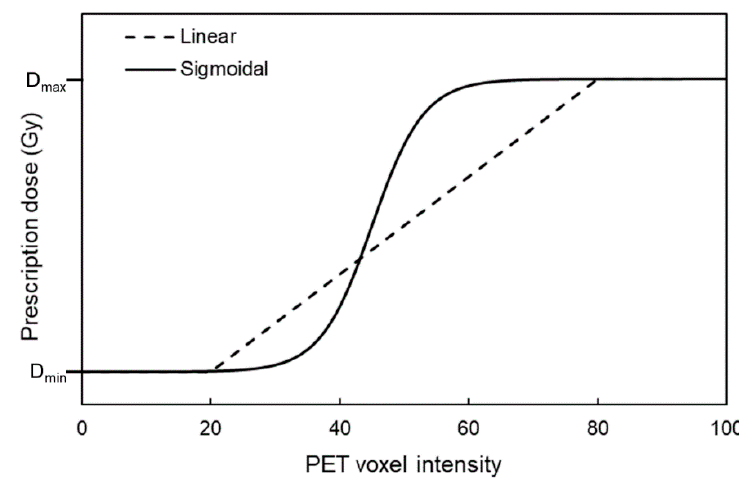
Figure 2. Linear and nonlinear (sigmoidal) prescription function relating the positron emission tomography (PET) voxel intensity to a local dose prescription for dose-painting-by-numbers (DPbN).